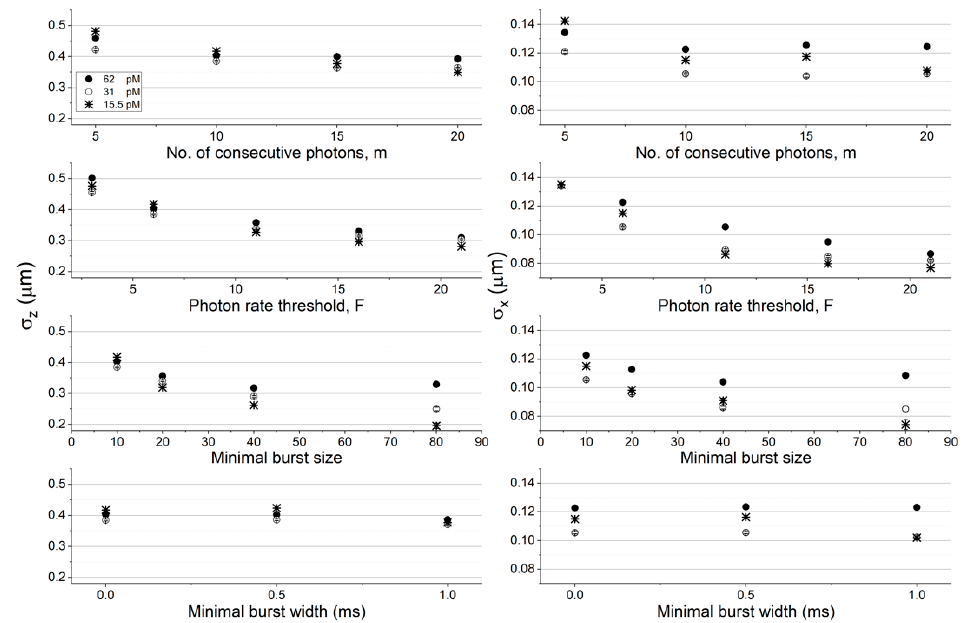
Figure 3. The molecular position dispersion as a function of burst search criteria and experimental conditions (different concentrations). Shown are the standard deviation of molecular positions in the z (left) and x (right) coordinates (the values in the y coordinate are the same as the ones in the x coordinate, in within the error ranges), when they emitted photons that were detected and selected by the burst analysis. The error values were calculated as the uncertainty of the standard deviation. All values are reported in Table S2. The assessment of the molecular position dispersion here is shown as a function of different concentrations for molecules diffusing with a constant diffusion coefficient of 90 μ m 2 /s, and in simulations using the numerical PSF model.